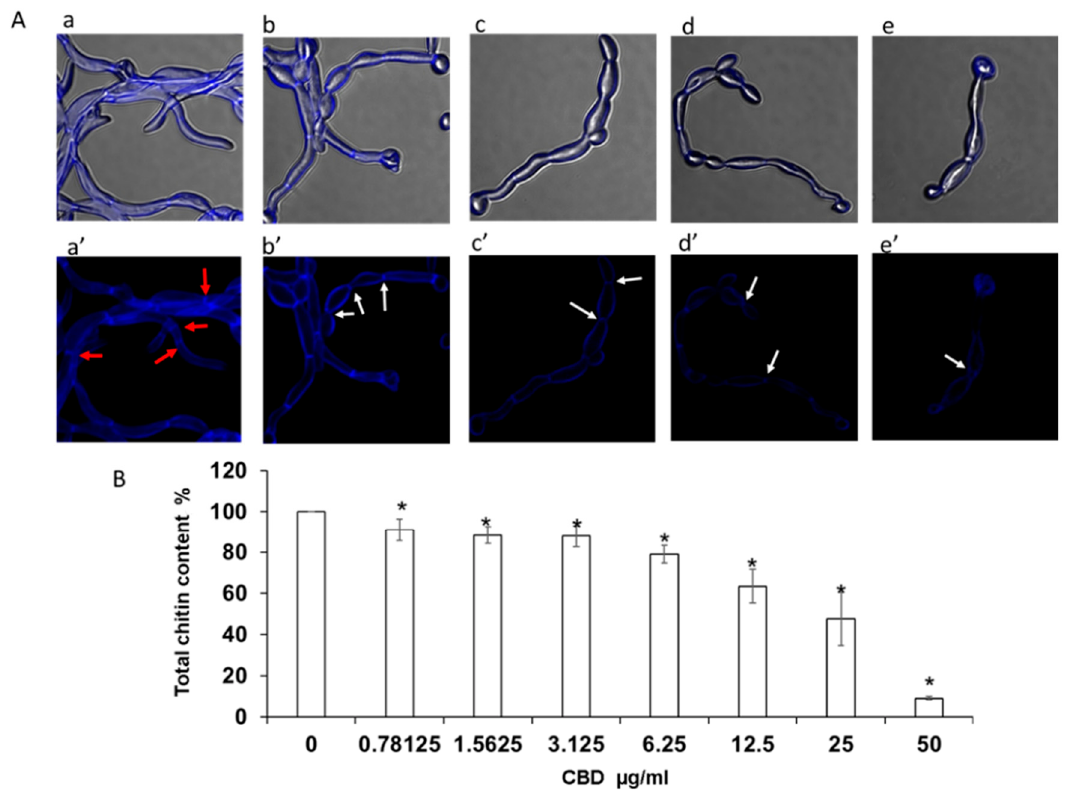
Figure 3. Determination of chitin content in biofilms. C. albicans biofilms after exposure to CBD for 24 h were stained with calcofluor white (CFW) for 5 min in the dark. ( A ). CFW-stained biofilms were observed by confocal laser scanning microscopy (CLSM). Phase-contrast and CFW stain merged images (a–e); CWF stain (a’–e’) of untreated control (a,a’); biofilms treated with 6.25 µ g/mL (b,b’), 12.5 µ g/mL (c,c’), 25 µ g/mL (d,d’), 50 µ g/mL (e,e’) of CBD. Red and white arrows indicate true septa and constrictions at the septal junctions, respectively. Magnification 600 × . ( B ). Total chitin content was measured according to the CFW fluorescence intensity measured in a plate reader. Data are presented as percentage of the untreated control. * Significantly lower than the untreated control ( p <